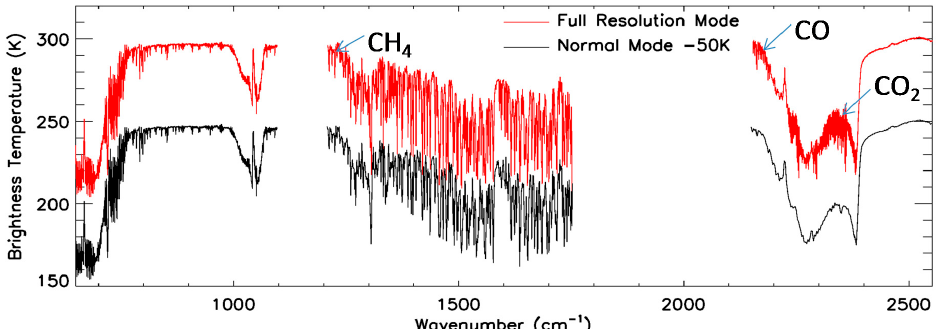
Figure 11. CrIS NSR/FSR. The full spectral resolution coupled with incredibly low noise in all three bands enables high quality CO and other trace gas retrievals. (Figure courtesy: Flavio Iturbide-Sanchez, STAR CrIS SDR team).